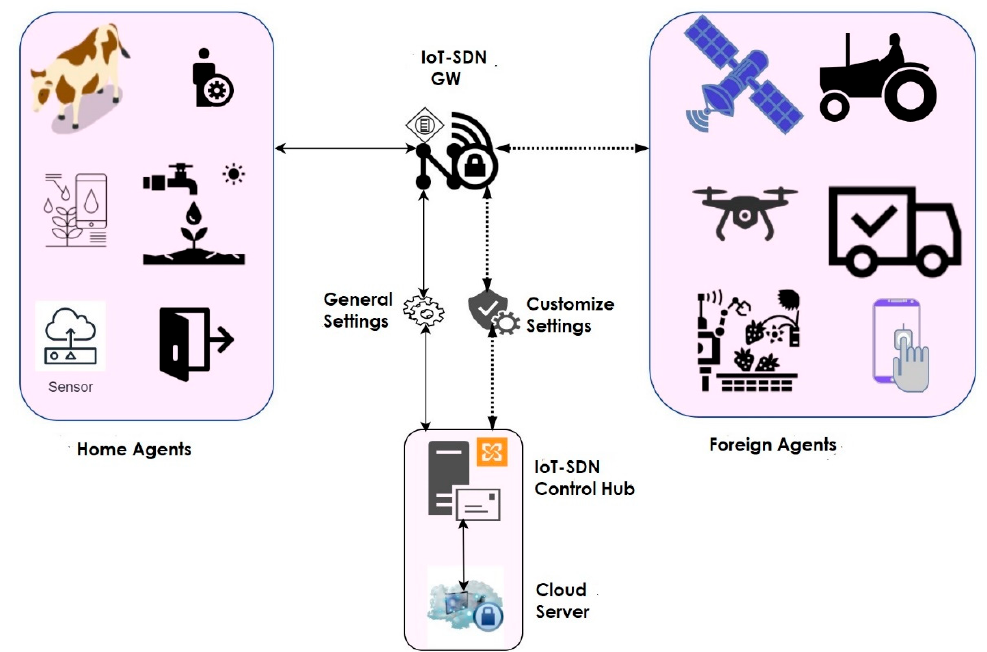
Figure 2. Foreign agent selection for IP rights management.